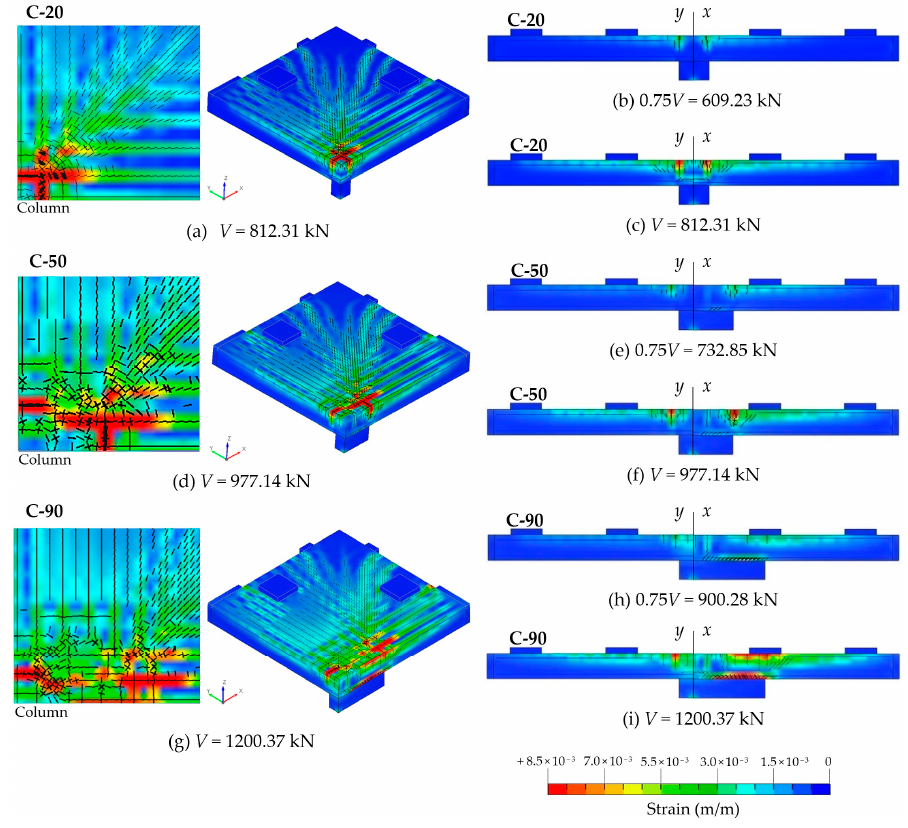
Figure 17. Cracking pattern of Series C models.